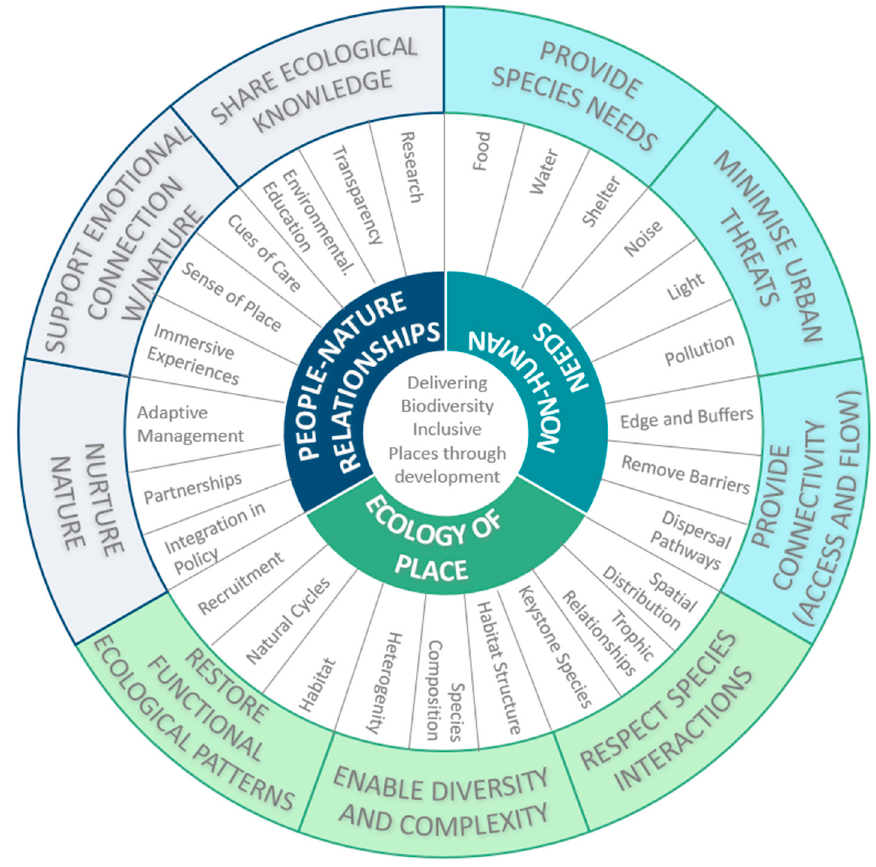
Figure 4. Dimensions, design principles and factors considered in BID Practice. In the middle is the overarching aim of BID as a design approach. Directly surrounding the aim, three core dimensions of BID design practice (the inner circle), the outer circle shows the BID nine design principles and the factors for consideration in BID are found between both circles.